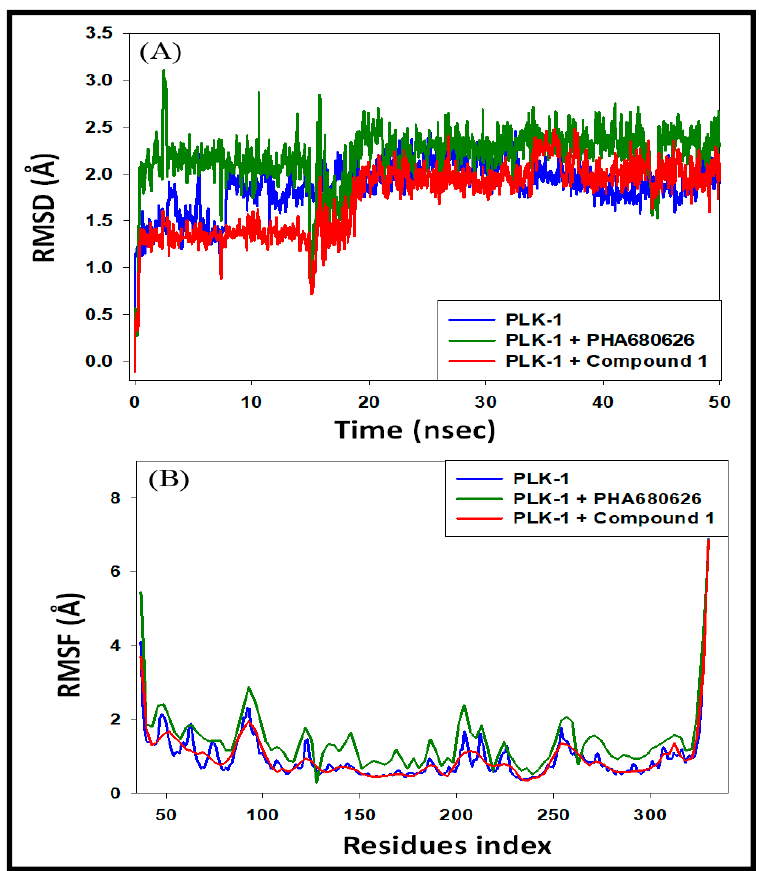
Figure 5. Molecular dynamics simulation of PLK-1 and compound 1 complex. ( A ) variation in root mean square deviation (RMSD). The curves in blue, green, and red show variations in PLK-1 alone, PLK-1-PHA680626 complex, and PLK-1-compound 1 complex. ( B ) variations in root mean square fluctuation (RMSF) as a function of simulation. The blue, green, and red curves show variation in RMSF of PLK-1, PLK-1-PHA680626 complex, and PLK-1-compound 1 complex, respectively.